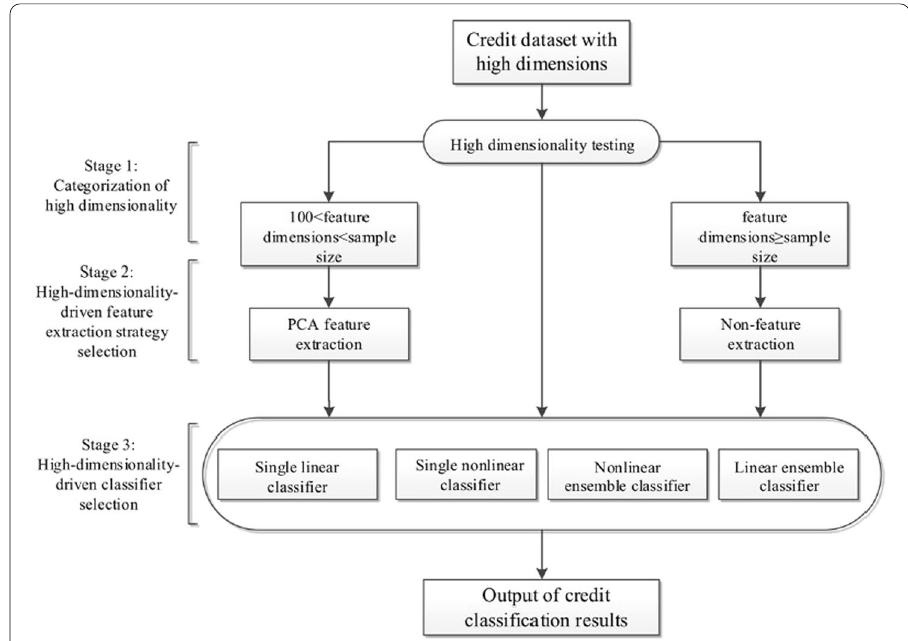
Fig. 1 General framework of high-dimensionality-trait-driven learning